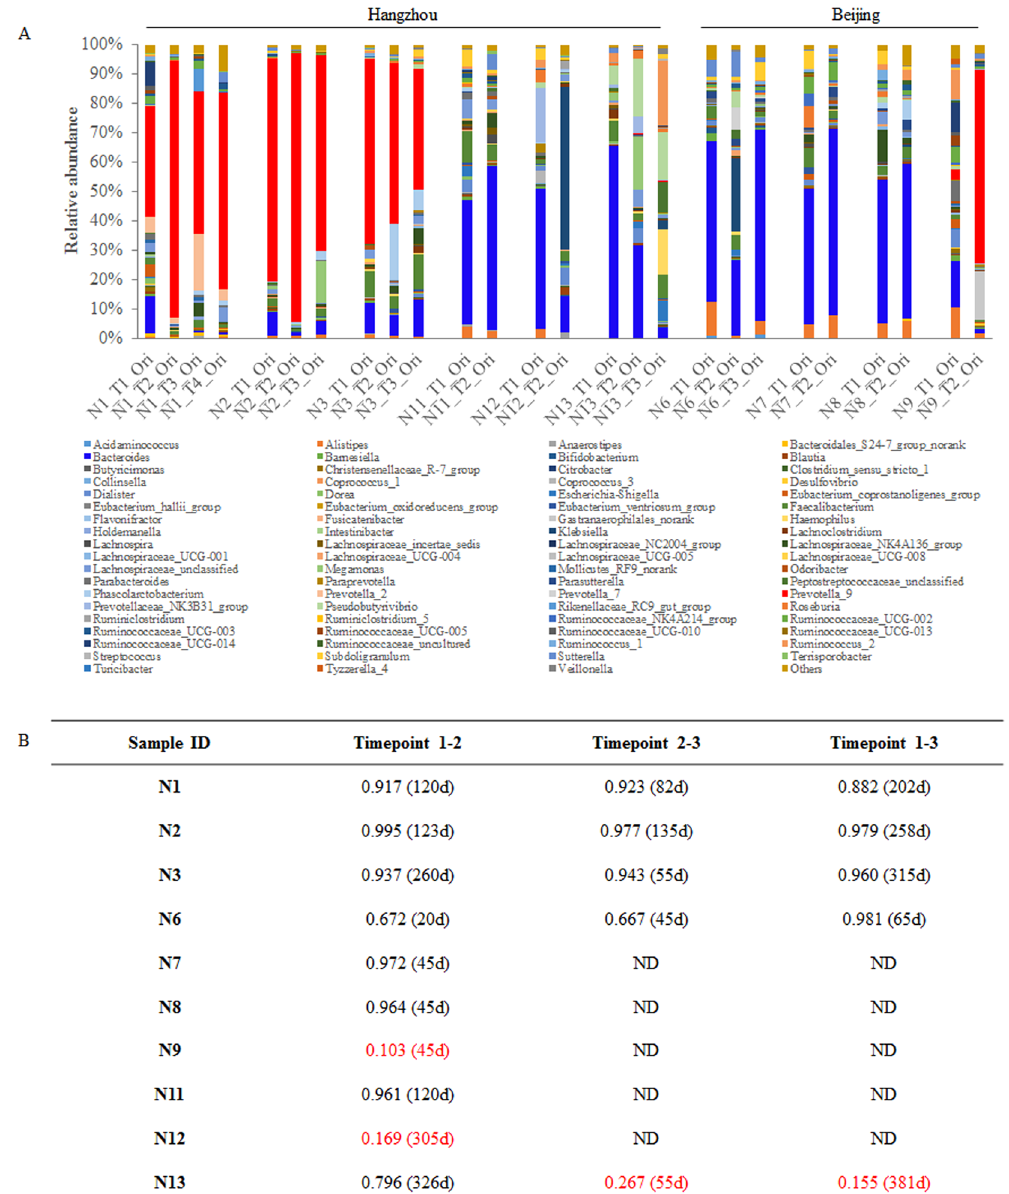
Figure 2. Stability of gut microbial enterotypes in Chinese hosts. Fecal samples were collected from ten healthy volunteers at different points in time. The bacterial community at the genus level is listed in Fig. 3A. The correlation coefficients of gut microbiota at different points in time are listed in Fig. 3B. The number in parentheses represents the number of days between two time